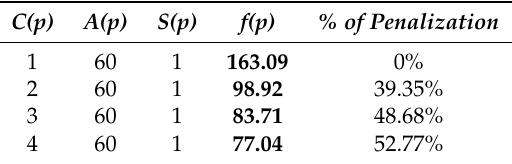
Table 2. Study of the relation between cost and utility and the influence of cost in the proposed cost–utility